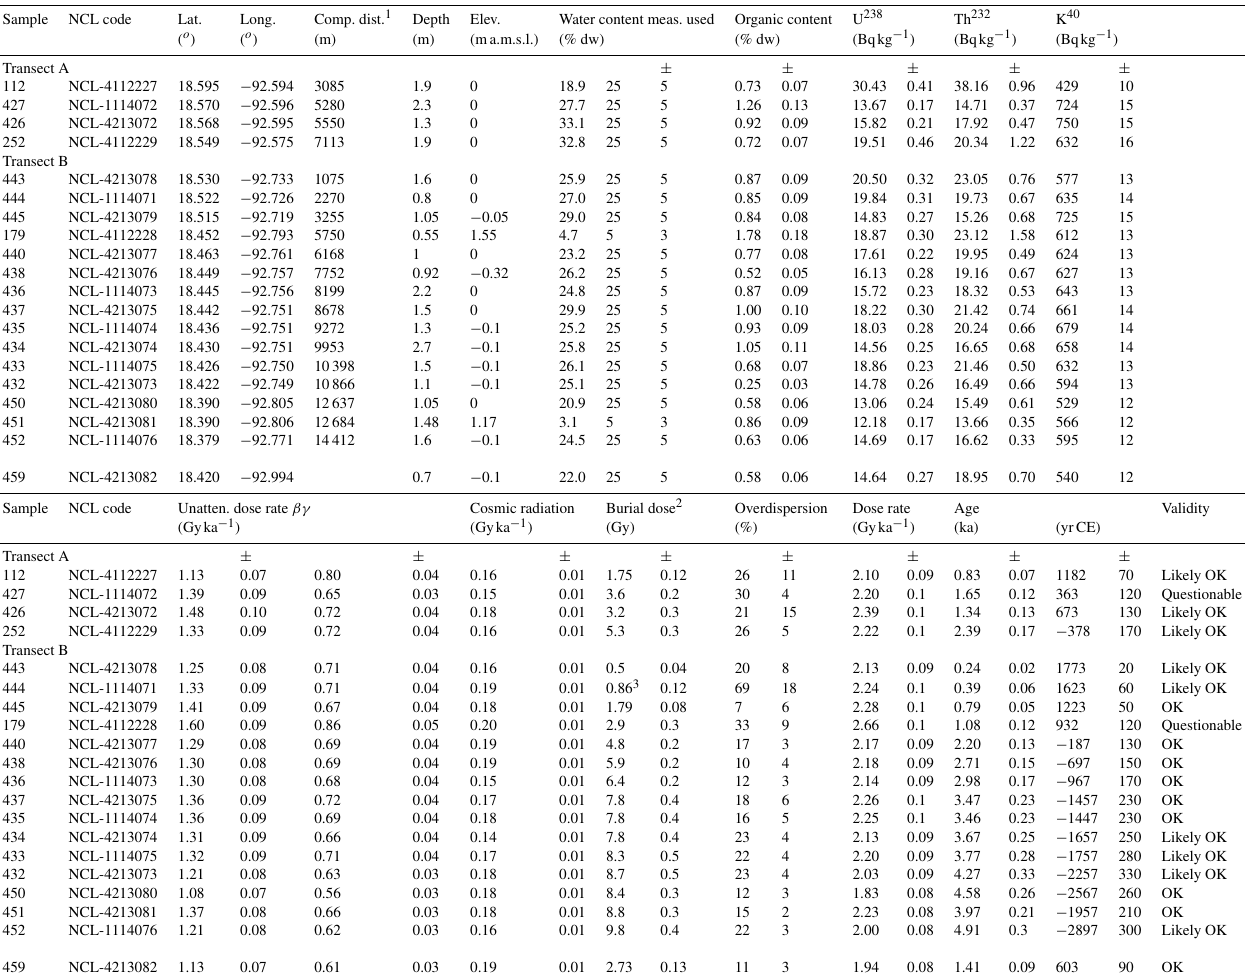
Table A2. OSL-dated samples. Sample NCL